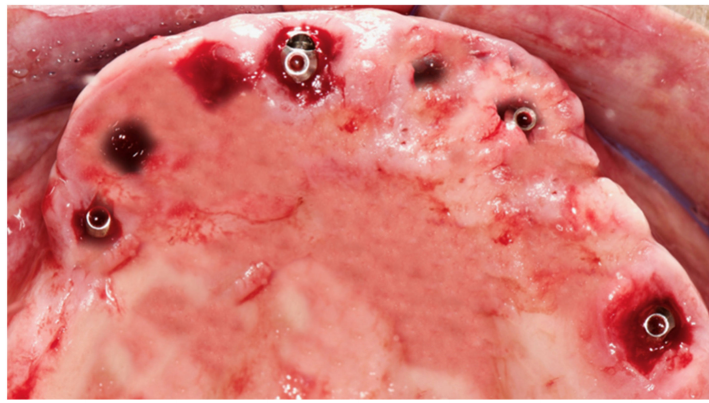
Figure 6. Multi-unit abutment were screwed on the implants after the